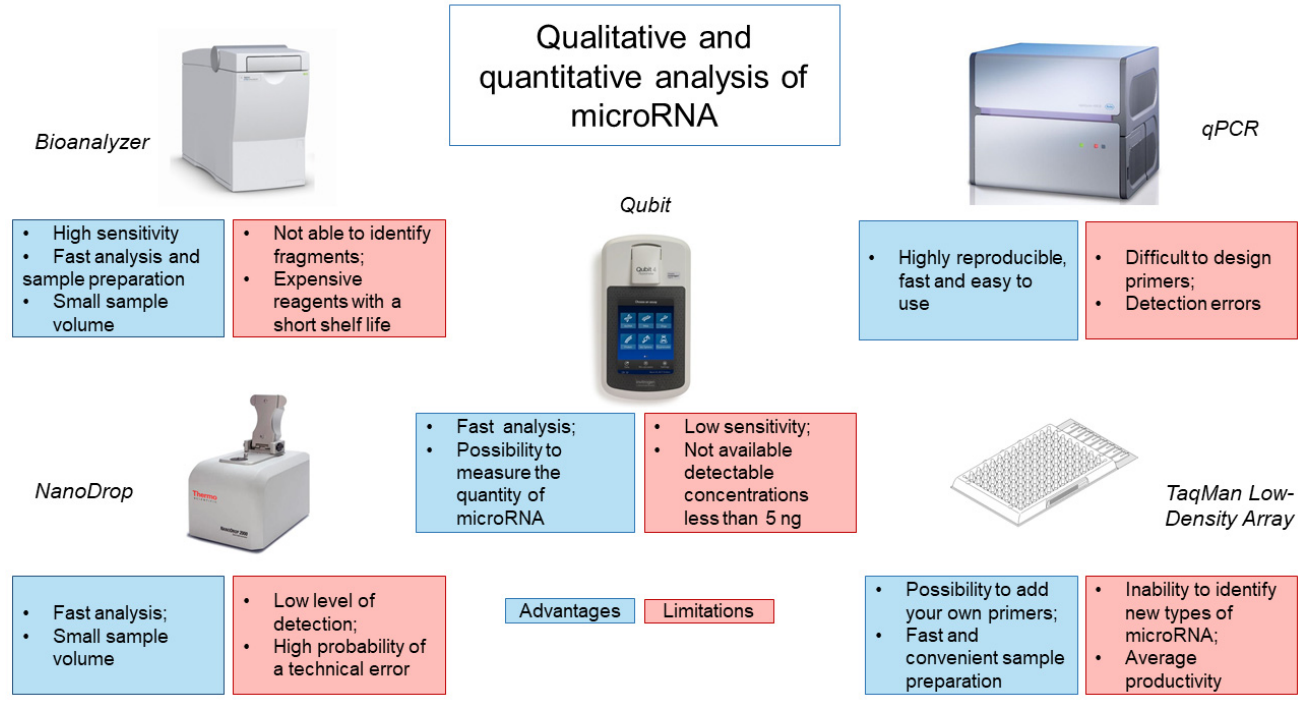
Figure 1. Analysis of methods for determining the quantity and quality of microRNA from CSF.